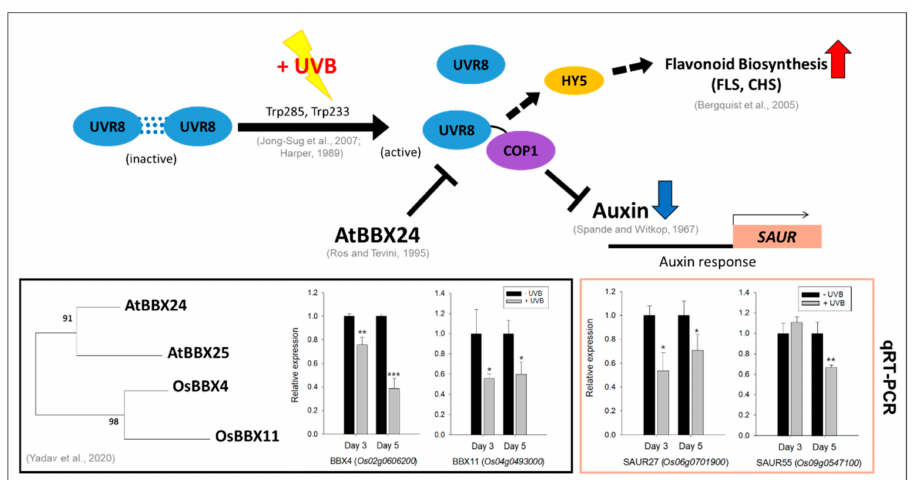
Figure 6. Expression of a negative regulator, OsBBX4 and OsBBX11 , and an auxin signaling- responsive gene, OsSAUR27 and OsSAUR55 ( n = 6), and the proposed UVB-triggered metabolic processes (flavonoid and auxin responses) in developing rice leaf blades. Flavonoids and tryptophan were significantly enhanced by UVB irradiation. Four genes, OsBBX4 , OsBBX11 , OsSAUR27, and OsSAUR55 were downregulated at days 3 and 5. Accordingly, it is assumed that auxin response is largely restricted by UVR8–COP1 and thus leads to the accumulation of tryptophan. Note: *, **, and *** mean p < 0.05, 0.01, and 0.001 (Student’s t -test) for qRT-PCR, respectively